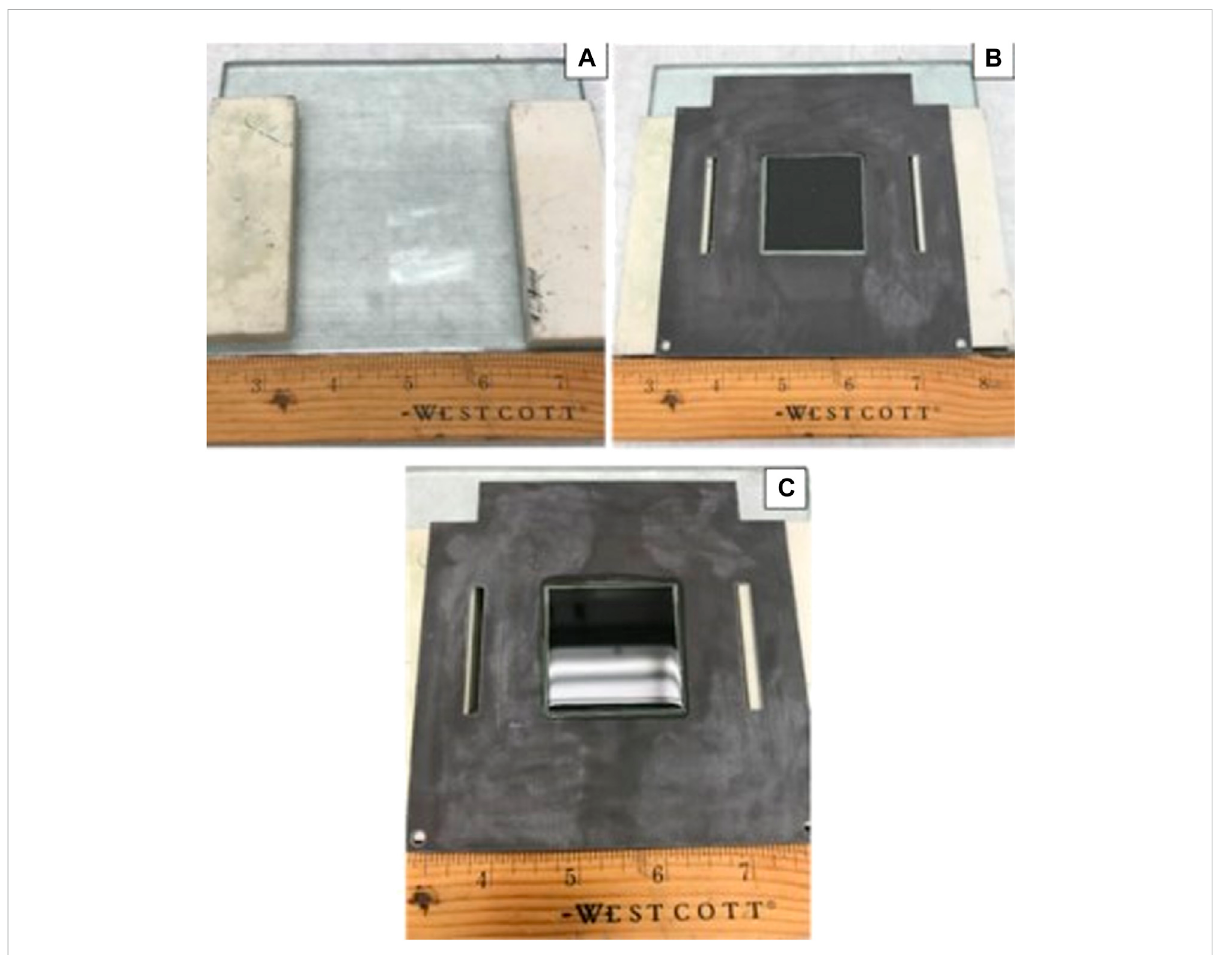
FIGURE 2 Roomtemperatureleaktestofasealedcell/windowframeassembly: (A) a fl atglassplatewithtwospacers; (B) asealedcell/cellframeassembly with cathode cavity facing up; (C) central cavity fi lled with